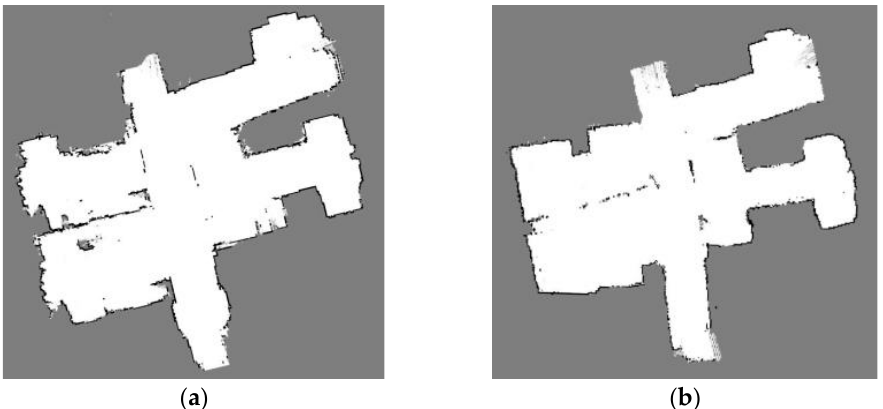
Figure 3. Comparison of two algorithms for simple indoor construction mapping: ( a ) Gmapping; ( b ) Cartographer.